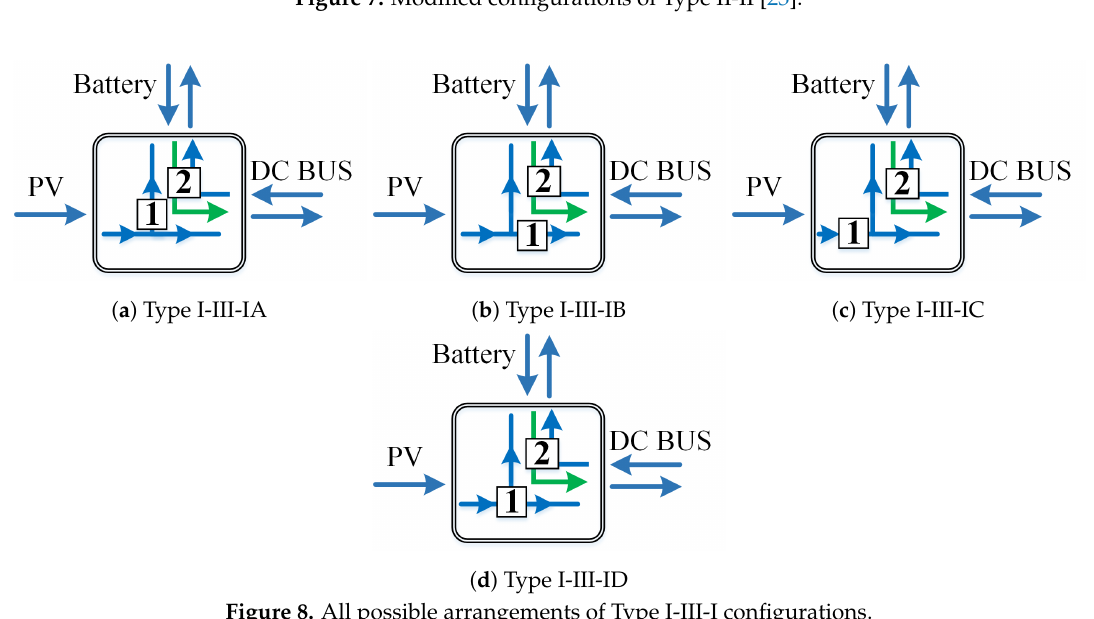
Figure 8. All possible arrangements of Type I-III-I configurations. Table 2. Possible combinations of proposed converter structures based on non-isolated basic DC/DC